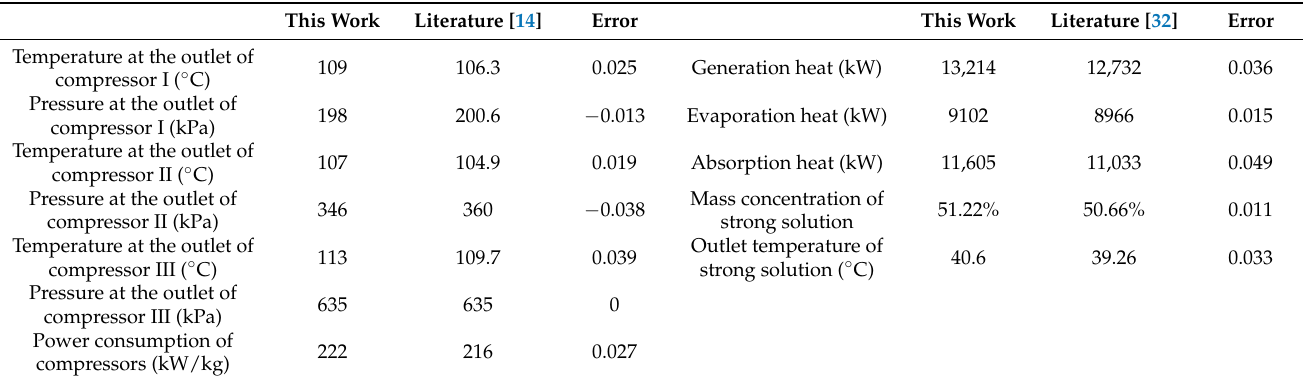
Table 4. Model verification of simulation results with reported